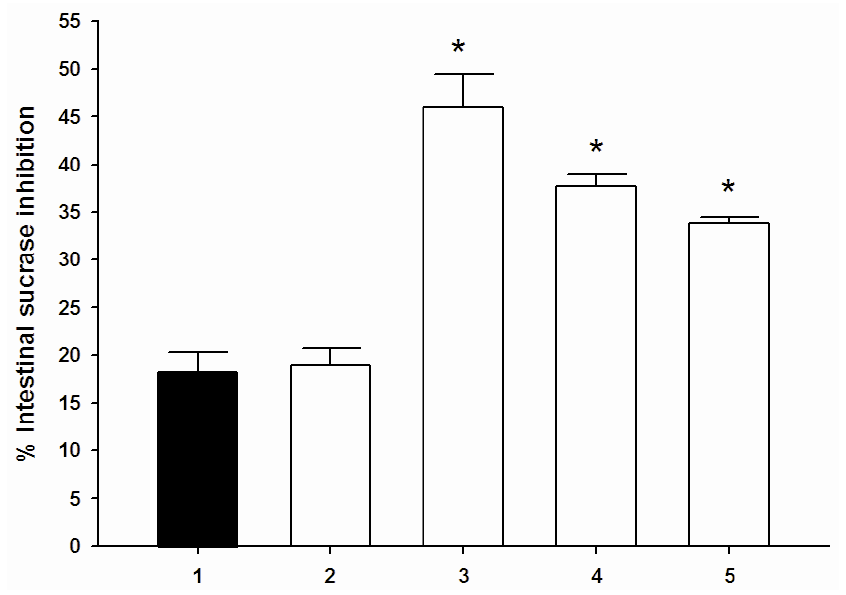
Figure 3. The combined effect of acabose and cyanidins on intestinal sucrase